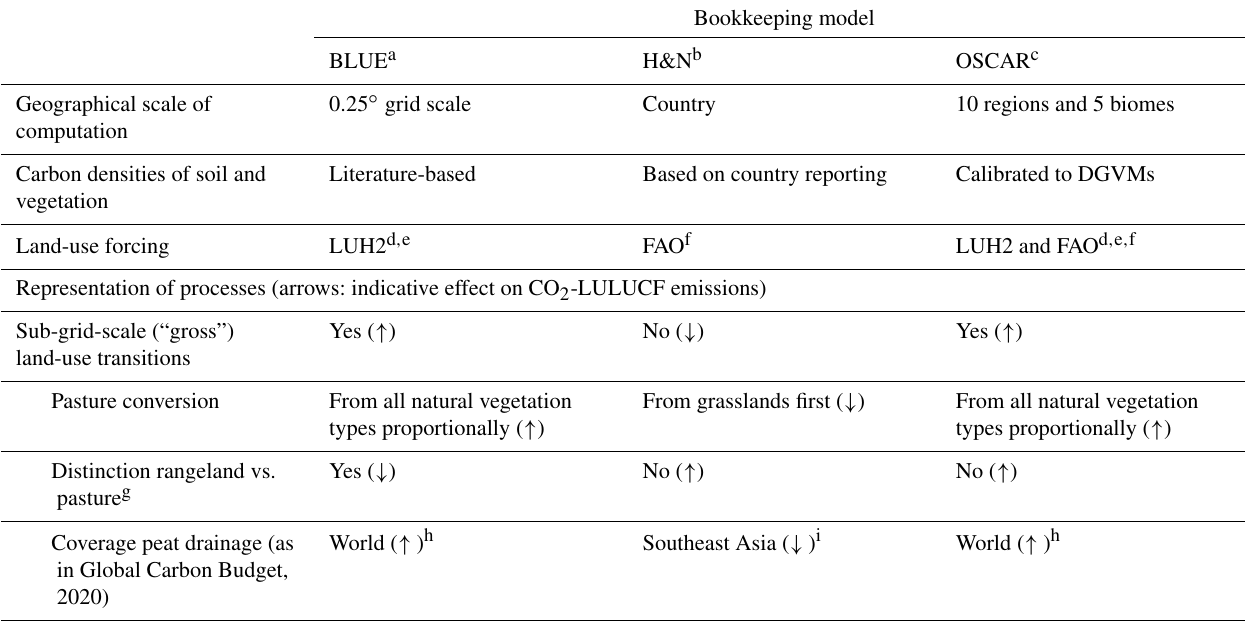
Table 4. Key differences between global bookkeeping estimates for CO 2 -LULUCF emissions. Notes: DGVM – dynamic global vegetation model; LUH2 and FAO refer to land-use forcing datasets; arrows indicate the tendency of a process to increase or decrease emissions compared to the other estimates’